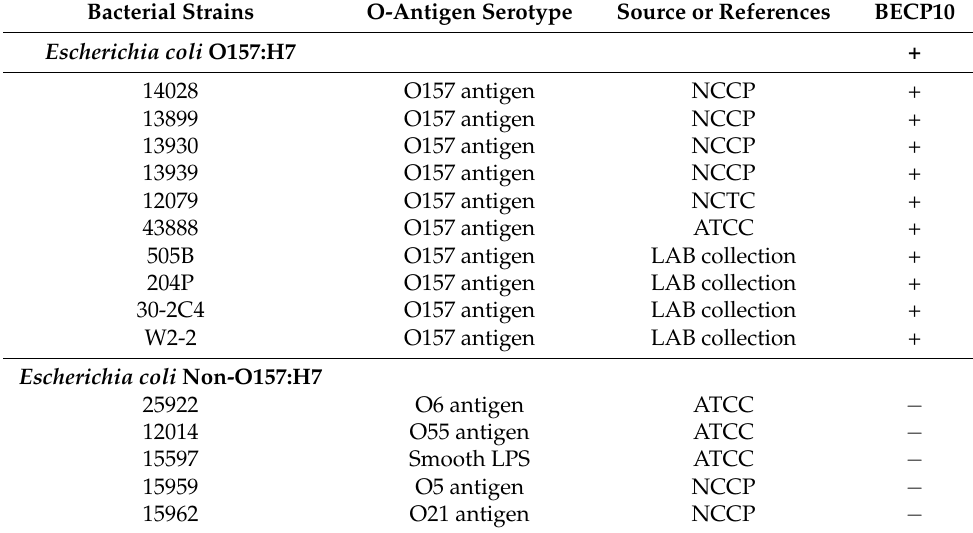
Table 1. Host spectrum of the phage,